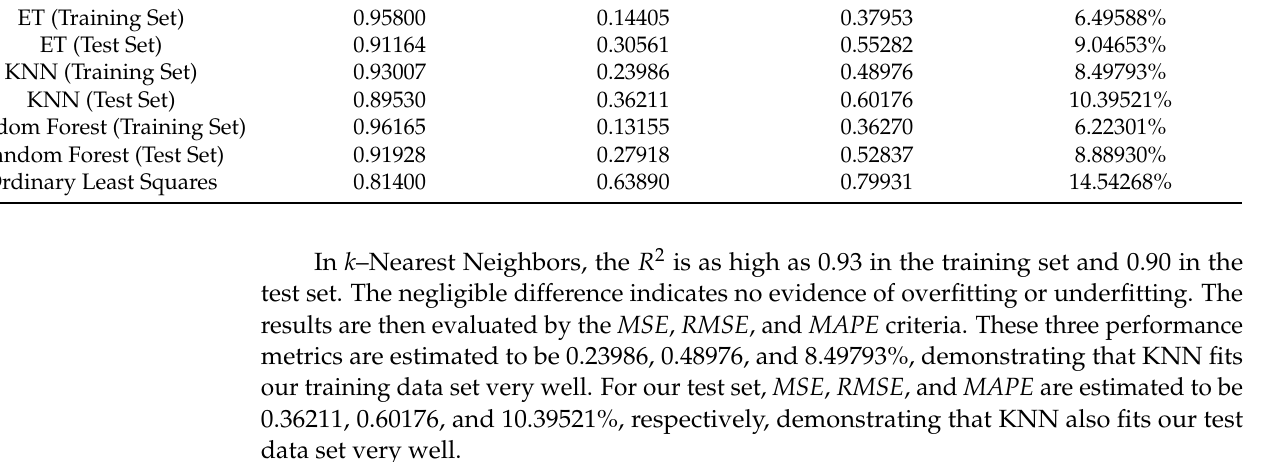
Table 3. Estimated results based on Random Forest and Ordinary Least Squares. R